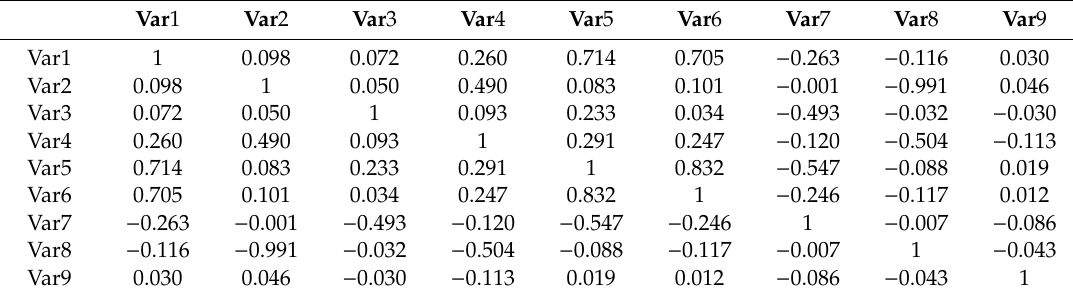
Table 3. Correlation